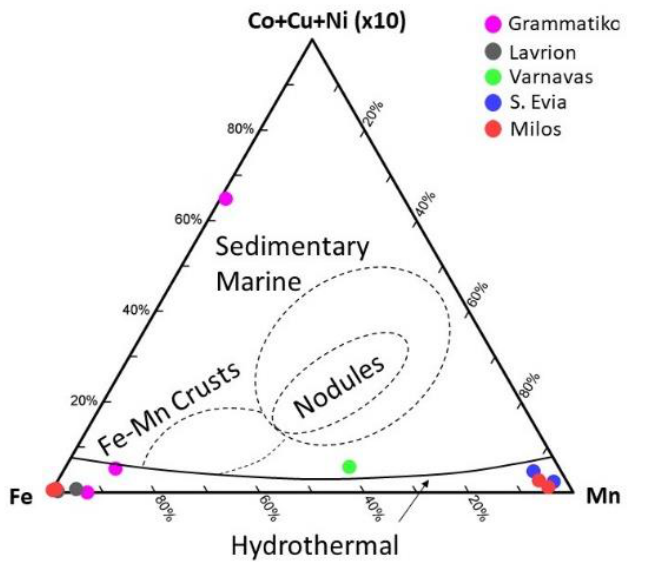
Figure 9. Ternary plot Mn-Fe-10 × (Ni + Cu + Co) discriminating marine hydrogenetic and hydrothermal Mn oxides (fields after [59–61]). Data from Table 2.